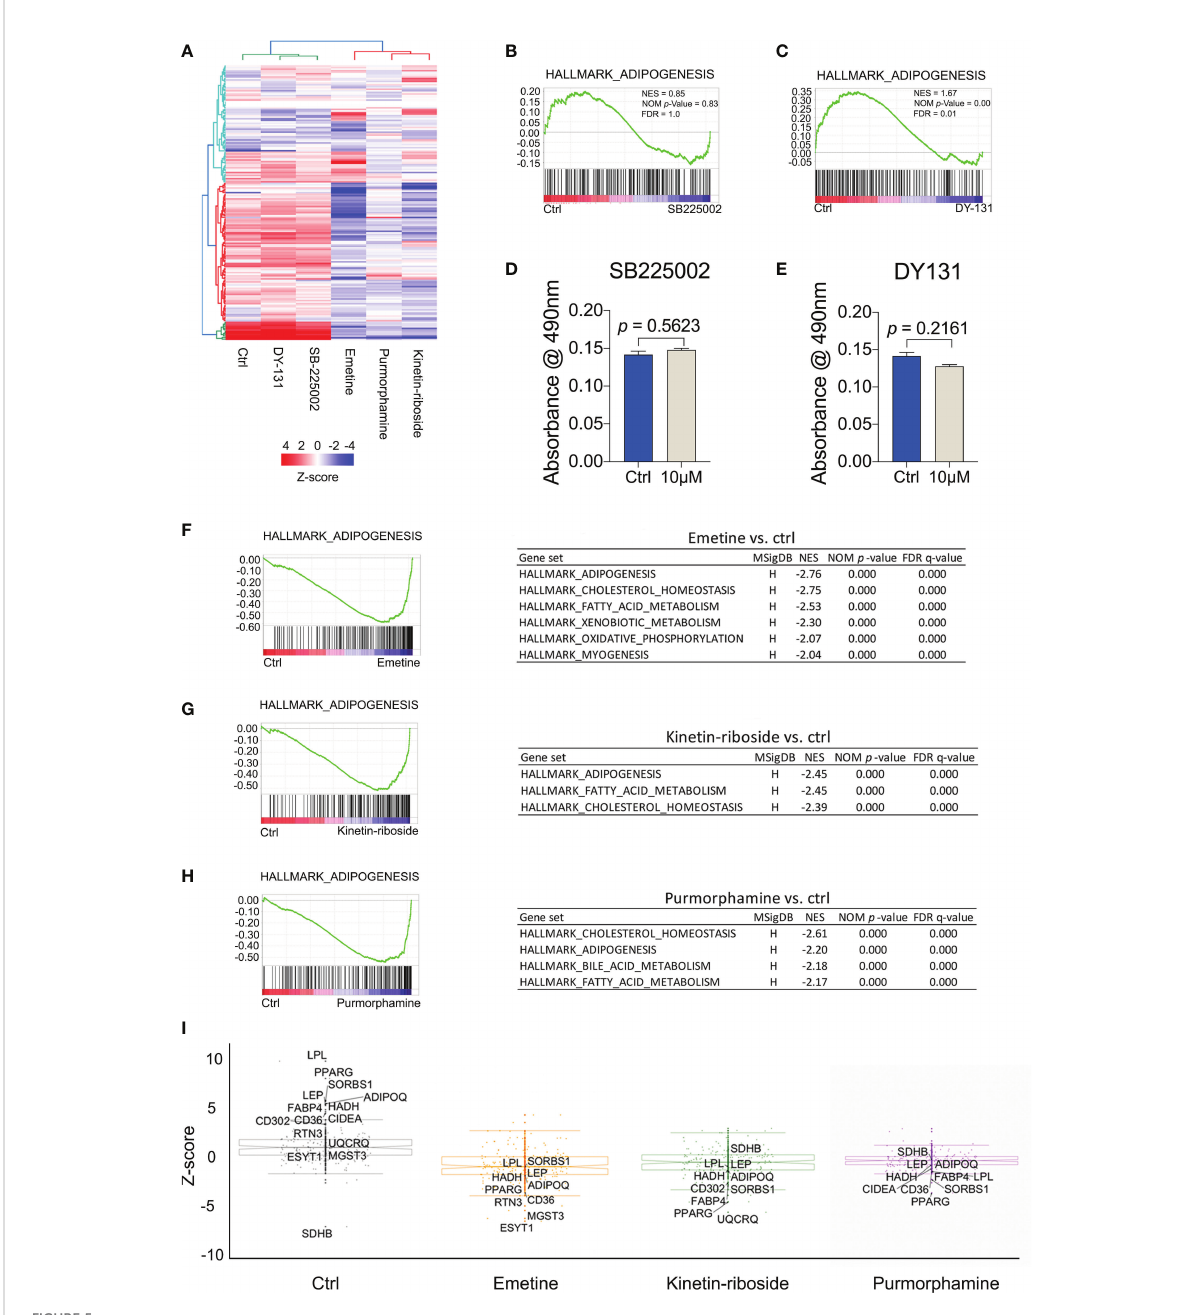
FIGURE 5 Transcriptomic signatures of BMSCs treated with prioritized compounds. (A) Heat map showing the expression pattern of emetine, kinetin- riboside and purmorphamine constructed with adipogenesis-related genes identi fi ed in the HALLMARK_ADIPOGENESIS gene set from The Molecular Signatures Database (MSigDB). (B, C) Gene set enrichment analyses (GSEA) of adipogenesis pathway following the treatment of SB225002 (B) , DY-131 (C) . (D, E) quantitative data of Oil Red O staining. Oil Red O staining was performed after 14 days of adipogenic differentiation from BMSCs following SB225002 (D) or DY-131 (E) treatment. (F – H) GSEA of decreased adipogenesis pathway following the treatment with emetine (F) , kinetin-riboside (G) and purmorphamine (H) . Gene sets with a NES less than -2 were shown in tables. (I) Box plots showing DE genes using robust Z-score (RZS). Compounds signatures were quanti fi ed by transforming normalized gene expression to RZS. The top 10 differentially expressed (D, E) genes with an absolute difference in RZS ≥ 2 (compound vs ctrl) following treatment with emetine, kinetin- riboside and purmorphamine were labeled with gene names. All gene names shown in the compound graphs were included in the control graph. Normalized enrichment score (NES), NOM p-value (normalized p -value), false discovery rate